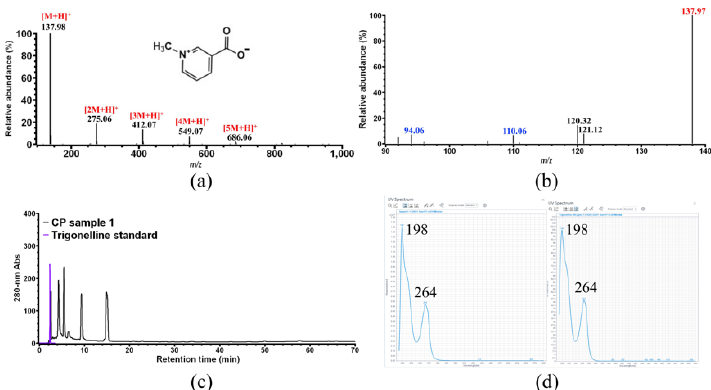
Figure 2. Identification of CP compound 1. ( a ) MS analysis of compound 1; ( b ) MS/MS analysis of the ion with m/z 137.98 obtained in ( a ); ( c ) HPLC overlay chromatogram of CP sample 1 and commercial trigonelline standard; ( d ) UV ‐ vis spectrum analysis of compound 1 and trigonelline standard.